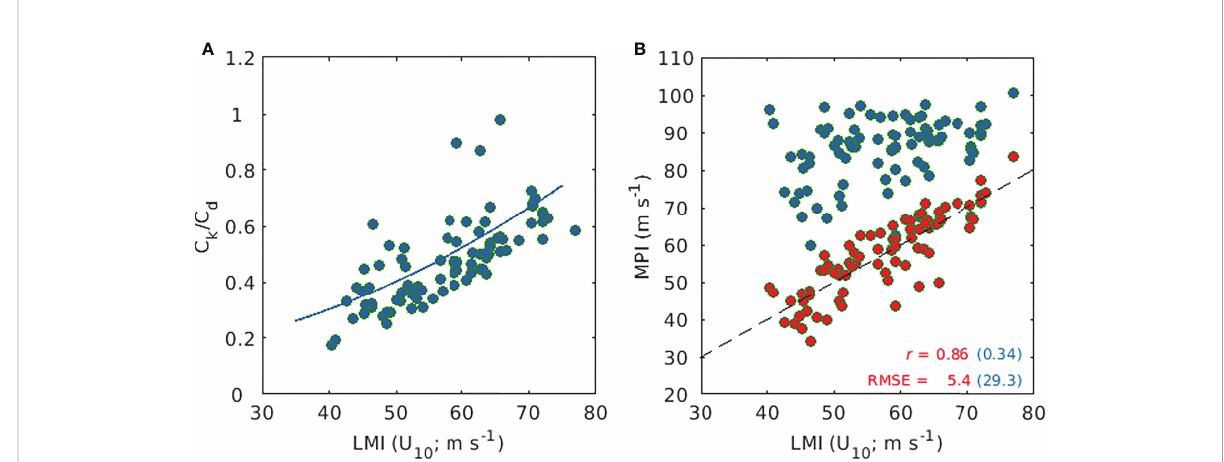
FIGURE 1 Scatter plot of C k / C d and theoretical MPI against LMI (i.e., MWS at 10 m, U 10 ) for major TCs. (A) Scatter diagram of C k / C d and its linear fi t (blue line, 1.1013e-04 U 102 + 0.1281) onto LMI. (B) Comparison of MPI calculated using unity (traditional way, blue dots) and linear fi t (red dots) estimated by present approach for C k / C d . Correlation coef fi cients ( r ) and root mean square errors (RMSEs, m s − 1 ) are shown in the lower right